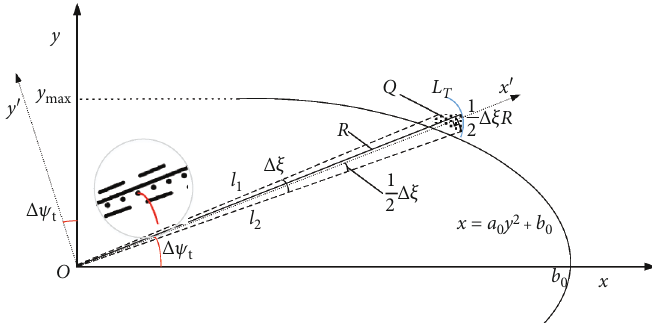
Figure 5: Description of the coverage requirements of the nonregular reachable area.